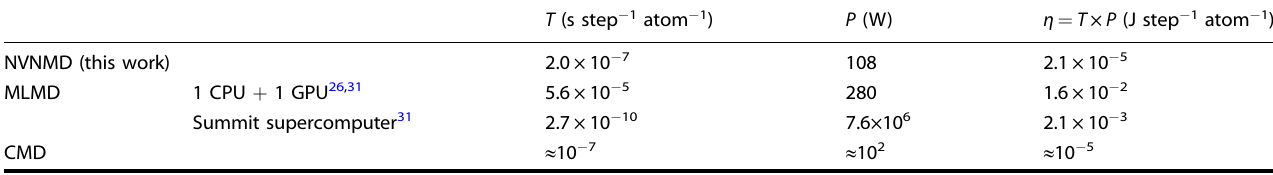
Table 6. Calculation energy ef fi ciency comparison between the proposed NVNMD and the established MLMD/CMD.